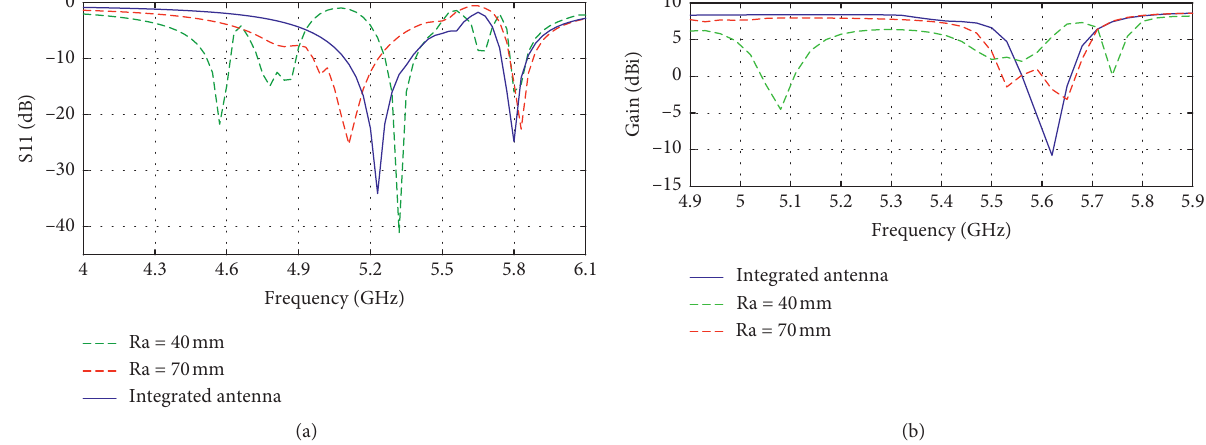
Ra = 40mm Ra = 70mm Integrated Figure 9: Structure deformation integrated MSs antenna: (a) S